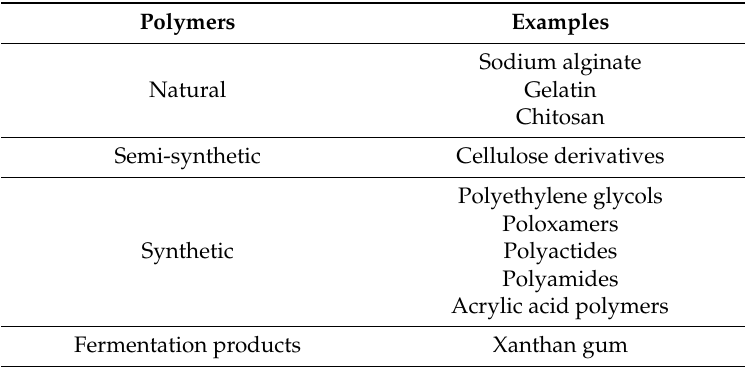
Table 3. Di ff erent types of polymers with some